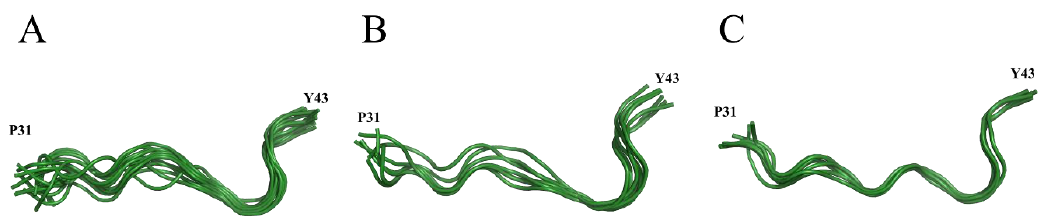
Figure 3. First three clusters of P31–43 NMR structures (ribbon representation) as clustered by Chimera software [24]. ( A ) Cluster 0, the most populated cluster collecting 14 structures over forty; ( B ) cluster 1 with 7 structures over forty; ( C ) cluster 2 with 7 structures over forty.